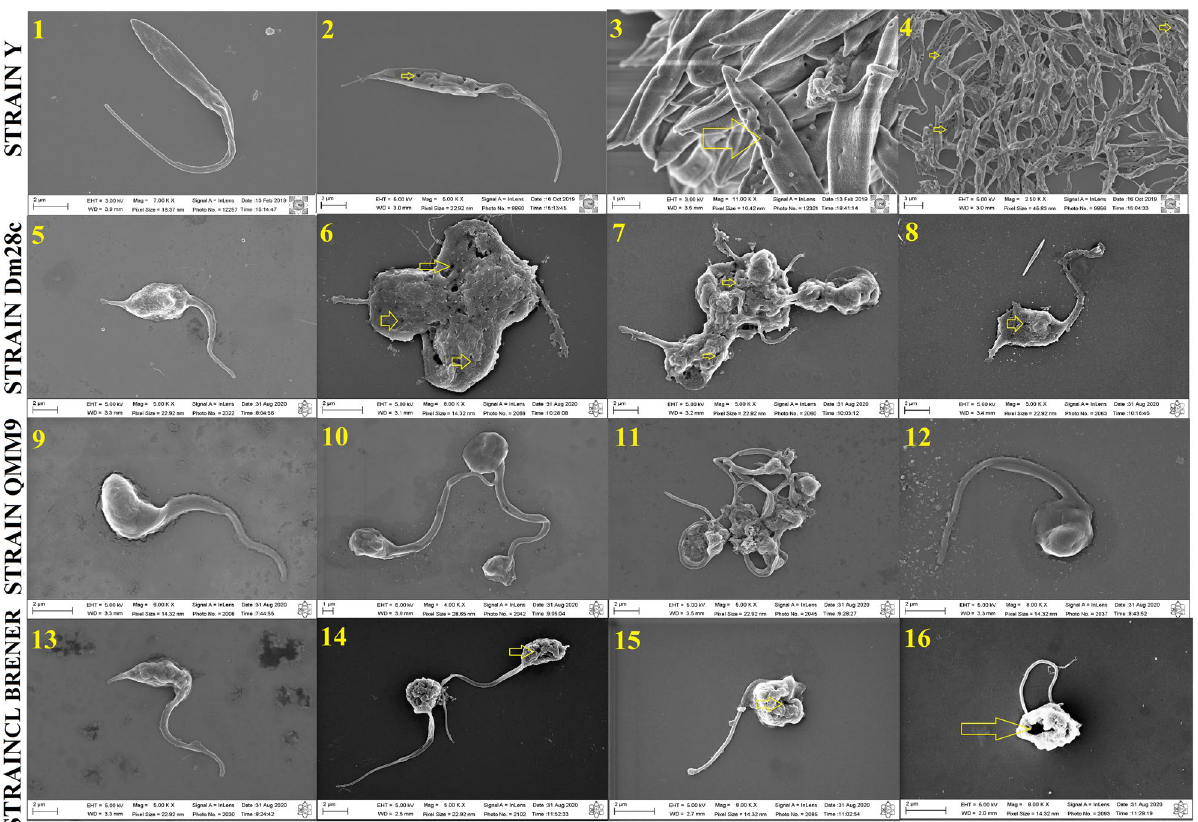
Figure 2. Morphological changes of Trypanosoma cruzi epimastigotes treated with diethyldithiocarbamate and analysed by scanning electron microscopy. Image 1 corresponding to the control of strain y, 2—4 corresponding to the treatment with DETC in concentrations 44 µM (2), 111 µM (3) and 222 µM (4); image 5 corresponding to the control of strain Dm28c, 6—8 corresponding to the treatment with DETC in concentrations 44 µM (6), 111 µM (7) and 222 µM (8); images 9 corresponding to the control of strain QMM9, 10—12 corresponding to the treatment with DETC in concentrations 44 µM (10), 111 µM (11) and 222 µM (12); and image 13 corresponding to the control of strain CL Brener corresponding to the treatment with DETC in concentrations 44 µM (14), 111 µM (15) and 222 µM (16), 14—16 . The yellow arrows in the figure indicate the presence of